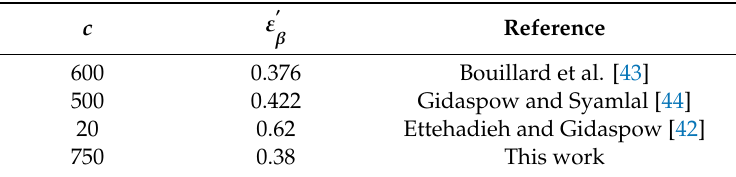
Table 1. Modulus of elasticity sub-model